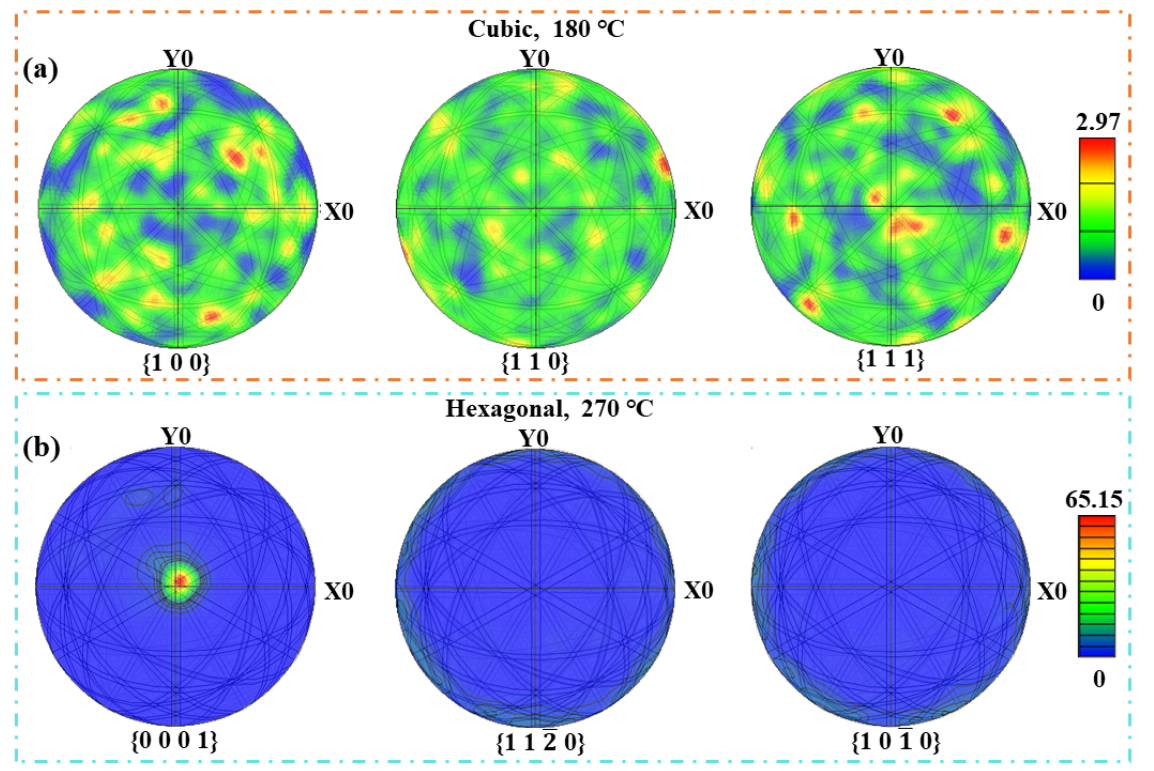
Figure 5. ( a ) EBSD pole figures for {100}, {110}, and {111} crystallographic planes for the f-phases film (180 ◦ C). ( b ) EBSD pole figures for {0001}, {1120}, and {1010} crystallographic planes for the h-phase films (270 °C).